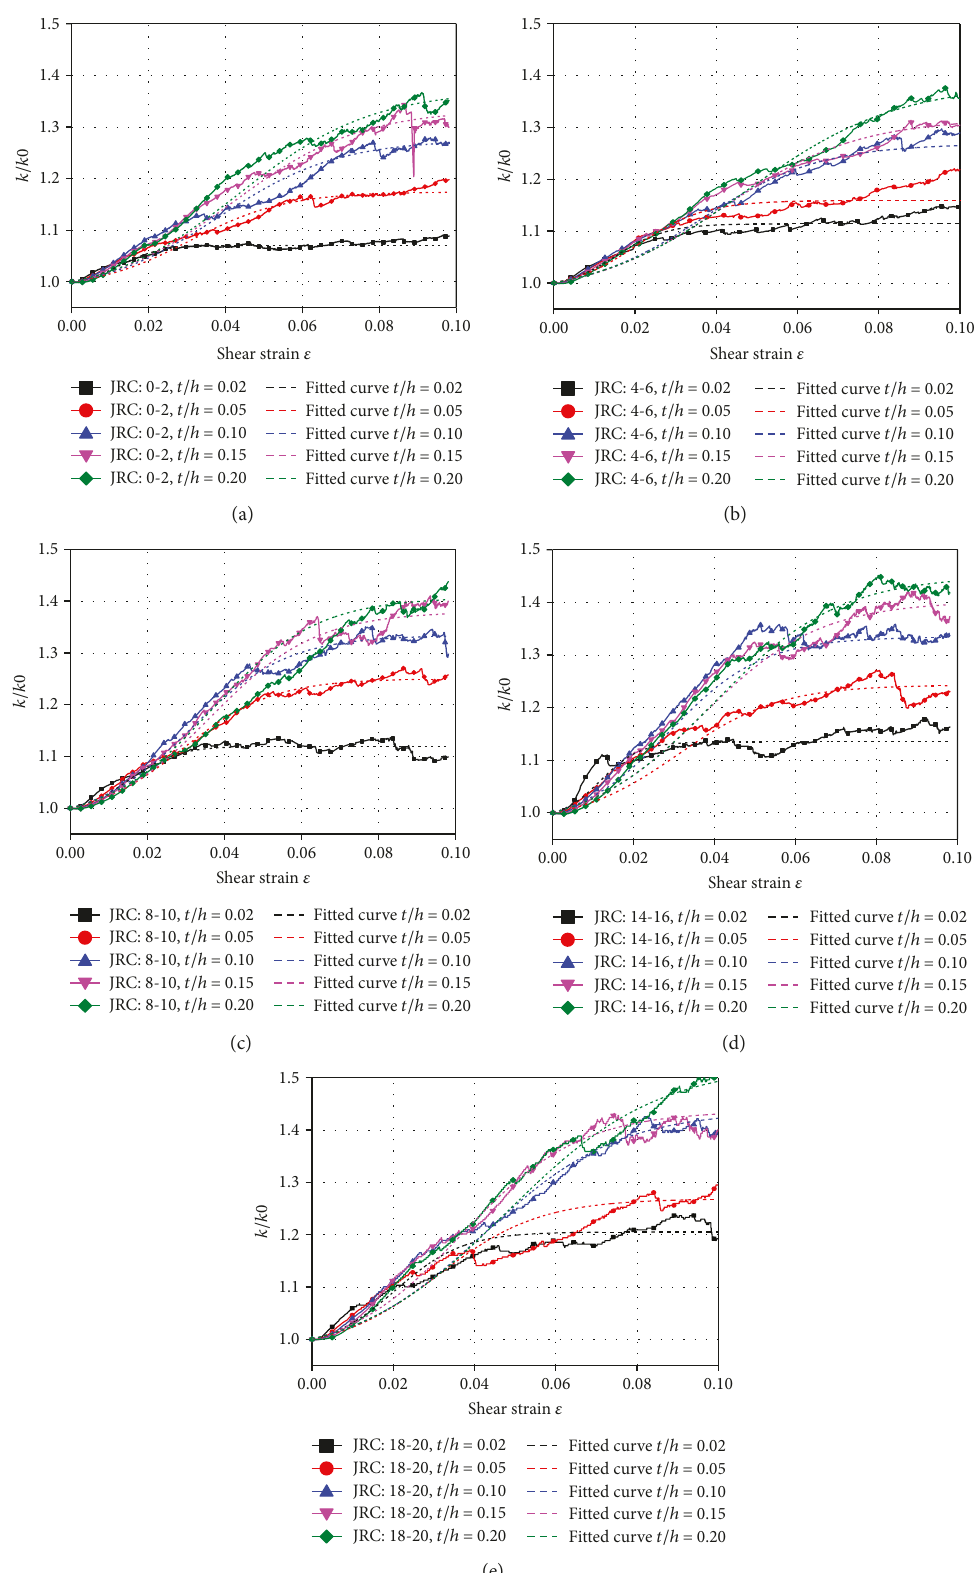
Figure 7: Typical relative di ff erence in permeability versus shear strain with di ff erent joint roughness coe ffi cients (JCRs) of (a) 0 – 2, (b) 4 – 6, (c) 8 – 10, (d) 14 – 16, and (e) 18 –